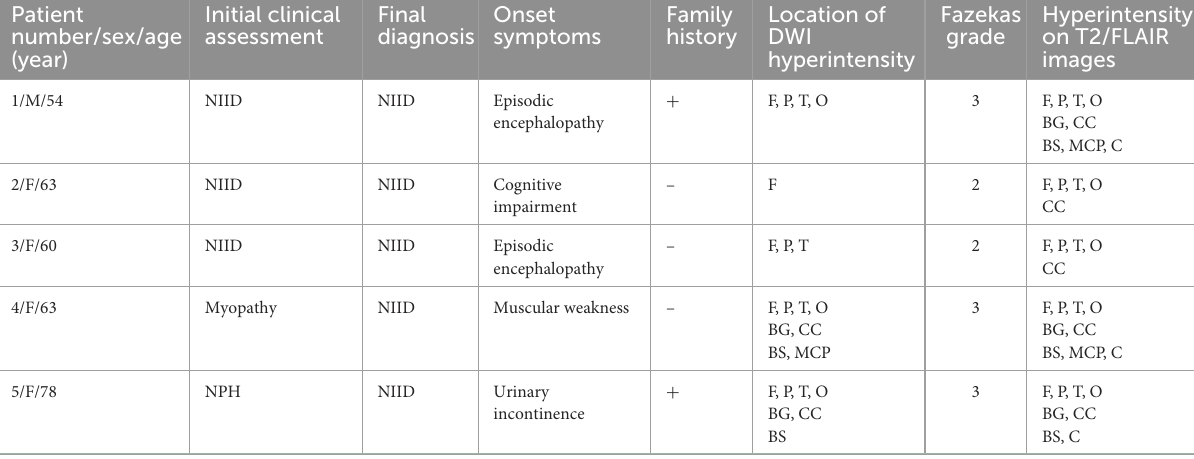
TABLE 1 Clinical and MRI findings in 5 patients with NIID identified from PACS. Patient number/sex/age